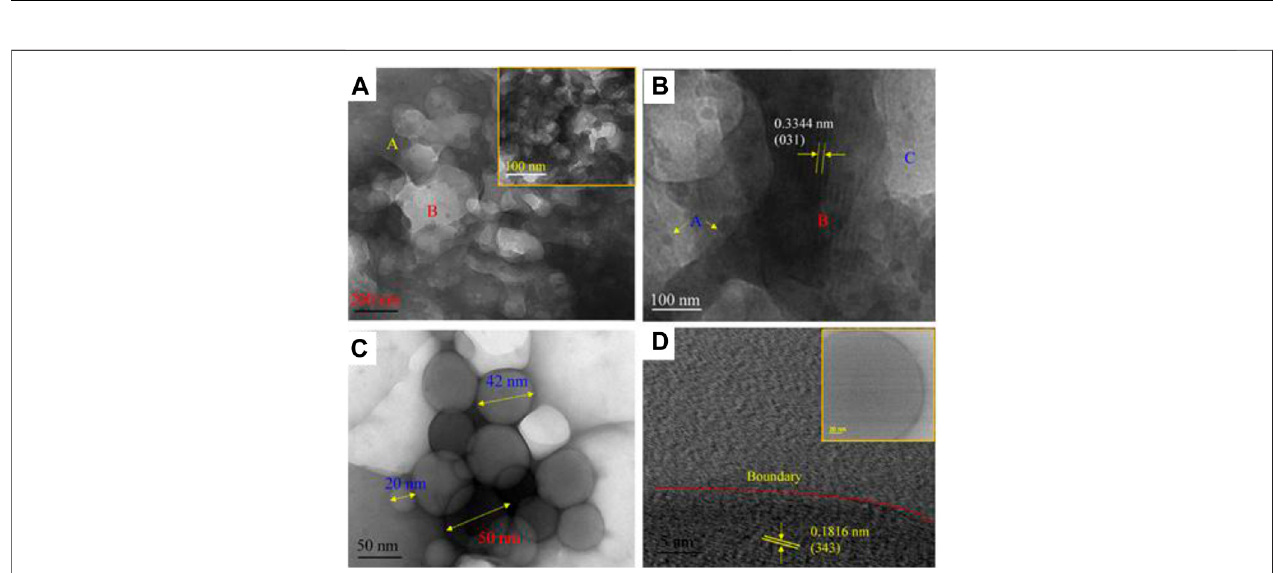
FIGURE 13 | (A) Schematic of the 120 V AC circuit, (B) Pictures of (left to right) postconsumer plastic as received from a recycler; after cutting using a commercial cutter; after mixing with 5 wt % CB; and further conversion to FG using AC-FJH.The fi gure is reprinted with permission from Algogeeb et al., 2020, Copyright 2020, American Chemical